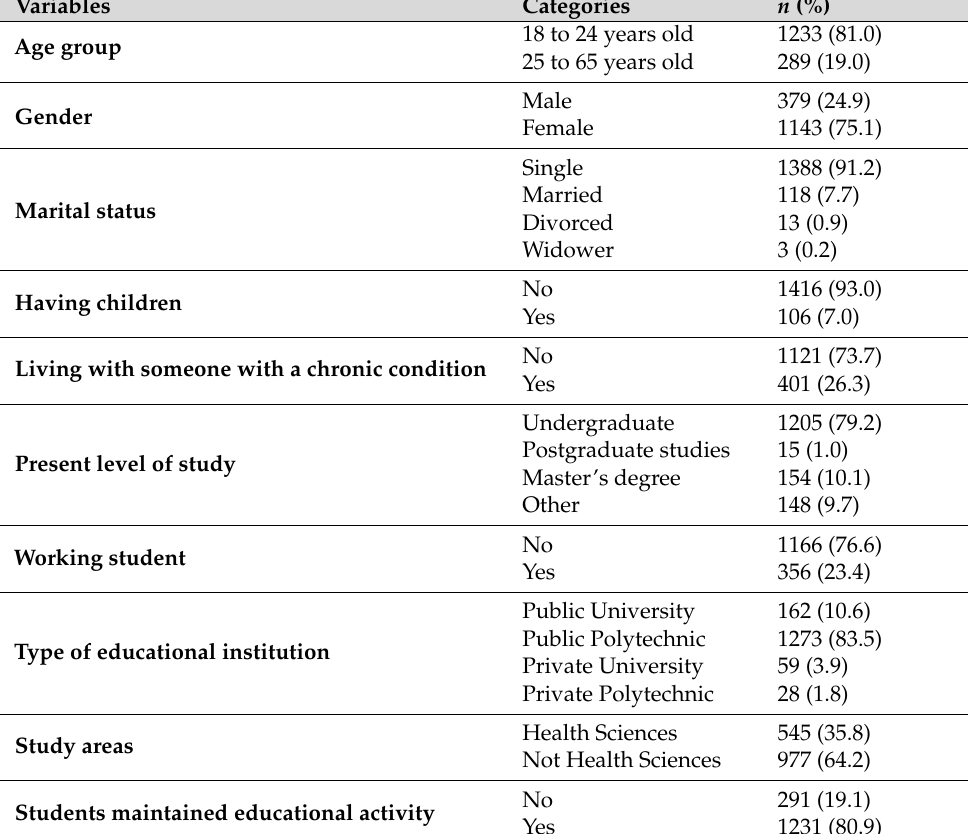
Table 1. Sociodemographic and academic characteristics ( n =